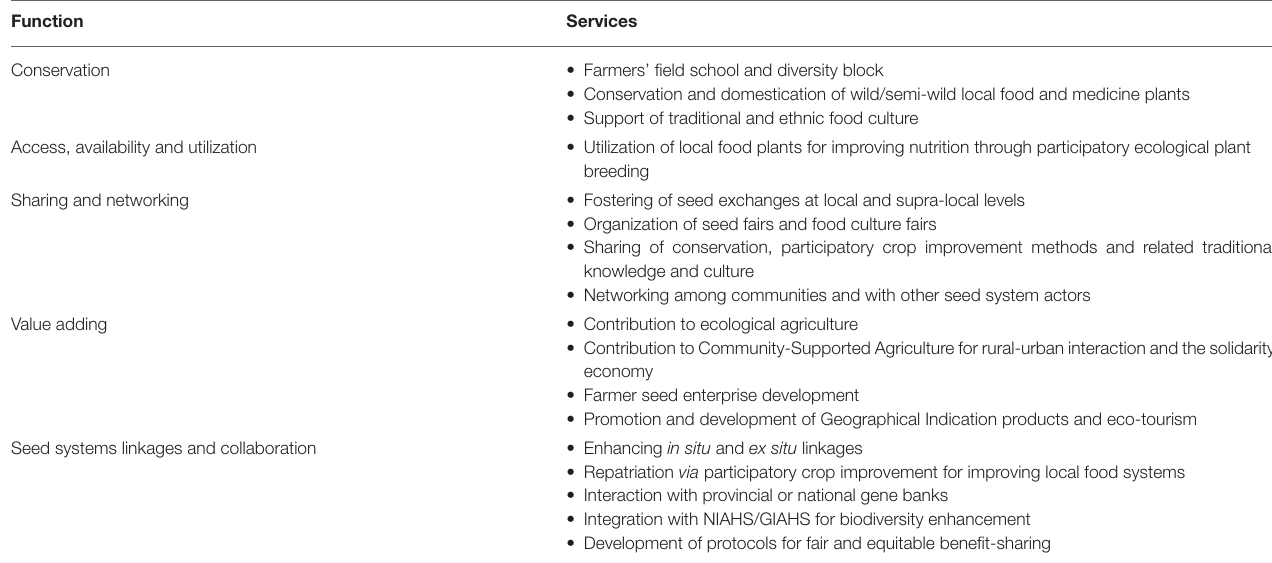
TABLE 4 | New functions and services of community seed banks in China.